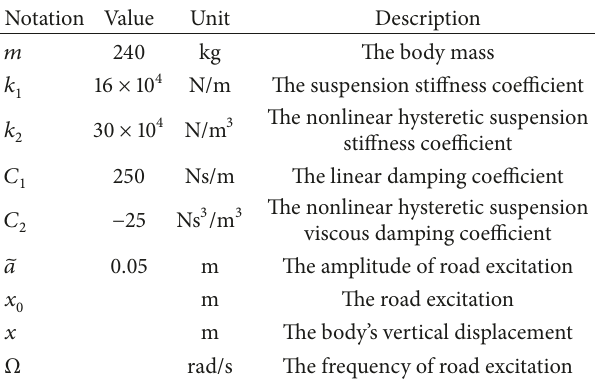
Figure 1: Schematic diagram of the quarter-car model. Table 1: Nomenclature and